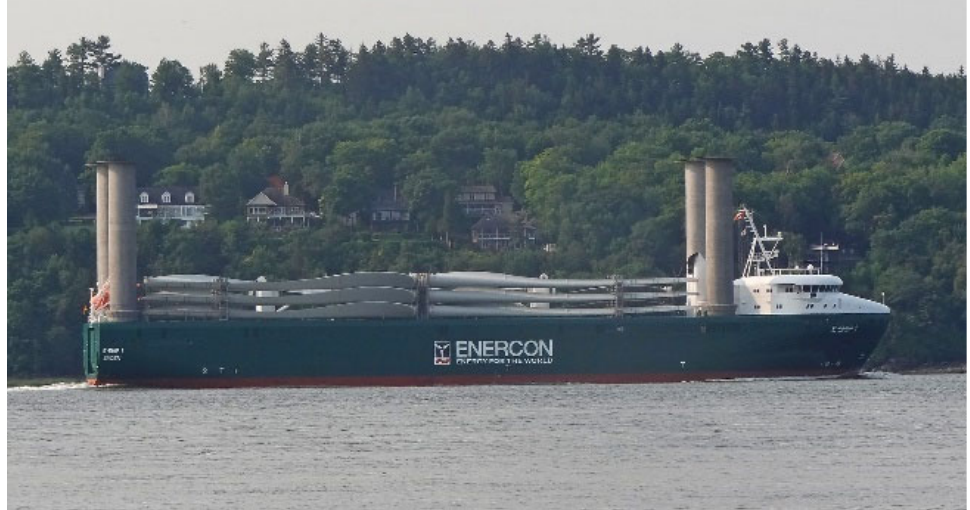
Figure 8. General cargo E ‐ Ship 1 traveling on the St ‐ Lawrence River in front of Quebec City, Canada.